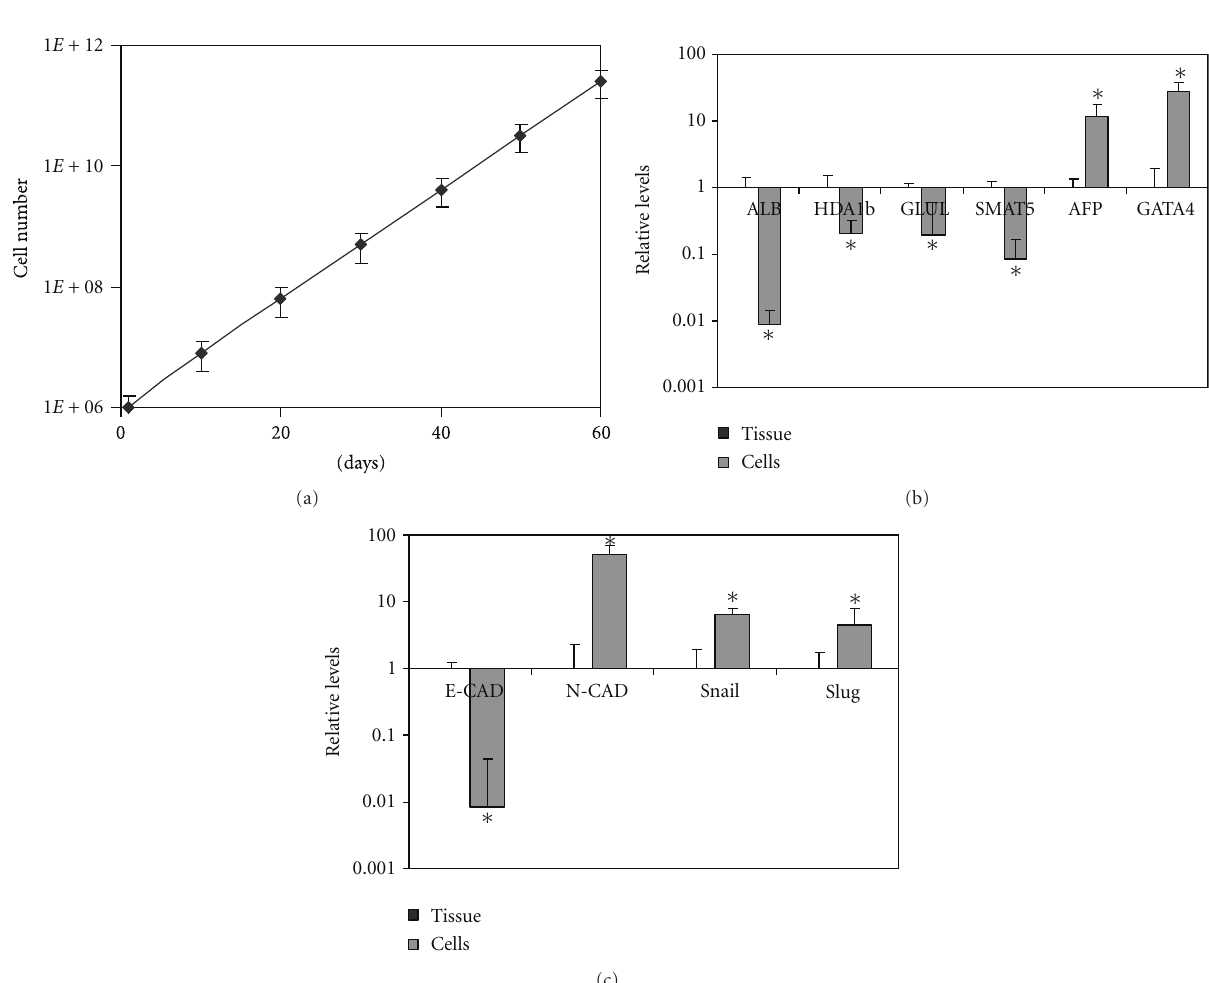
Figure 1: Proliferating adult human liver cells in culture undergo hepatic dedi ff erentiation associated with EMT marker expression. (a) Growth curve of adult human liver cells supplemented with exendin-4 (5nM) [11]. (b) Quantitative RT-PCR analysis of hepatic (albumin, ADH1b, GLUL, SMAT5, and AFP), endodermal (GATA4) and (c) EMT (E-CAD, N-CAD, Snail, and Slug) markers in primary cultures of adult human liver cells ( n = 4, P2–4) compared to intact adult human liver tissue ( n = 4). The results are normalized to β -actin expression within the same cDNA sample and presented as the relative levels of the mean ± standard deviation of primary cultures versus liver tissue. ∗ P < 0 .